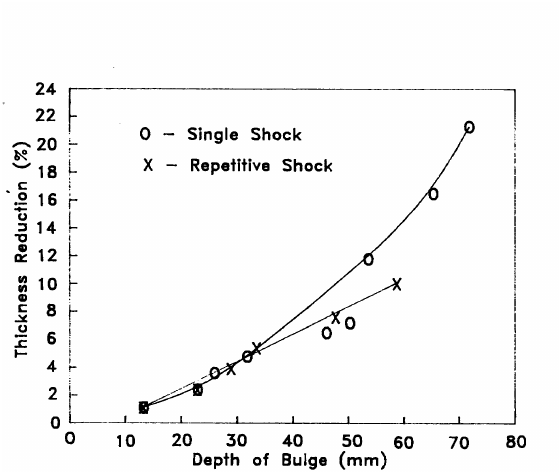
FIGURE 7 Dependence of percentage thinning on depth of bulge for single and repetitive shock.